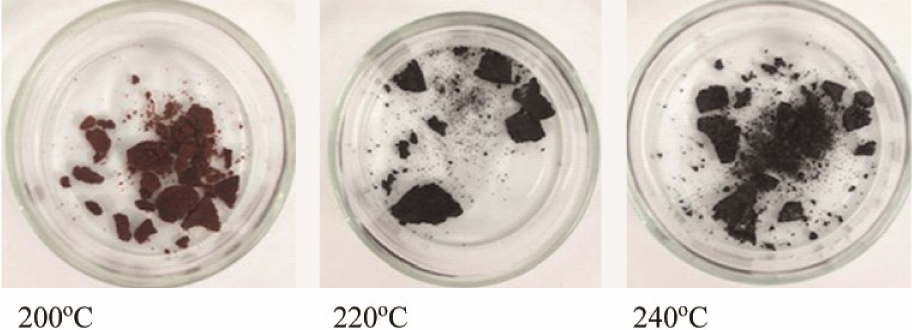
Figure 1. Physical appearance of pyrolyzed PVC-P; PVC/glycerol mass ratio = 2/3 (PVC = 0.4 g, glycerol = 0.6 g), reaction time = 120